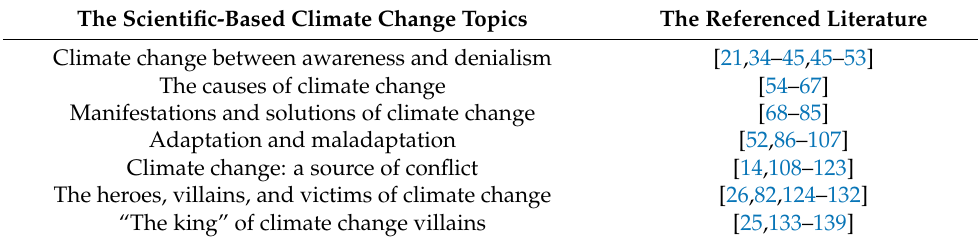
Table 1. The referenced literature for the scientific-based climate change